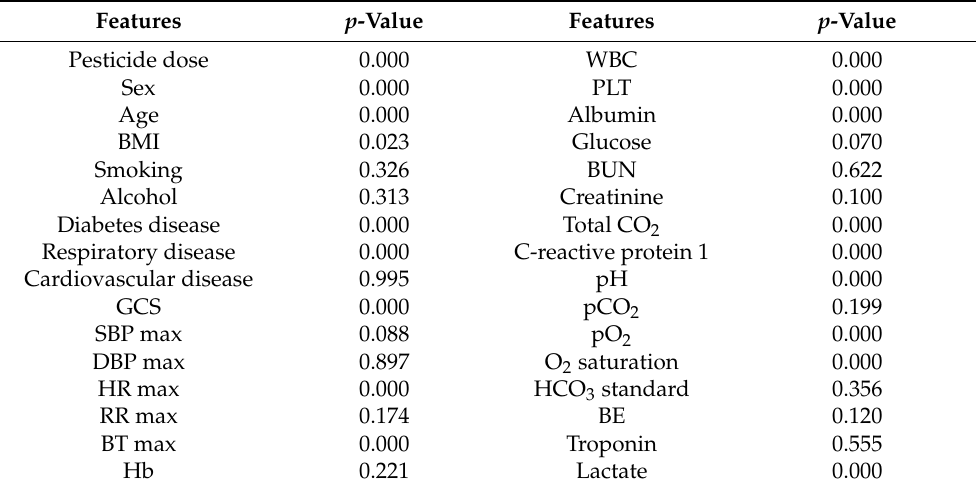
Table 1. The respiratory failure was correlated to p -values of features.